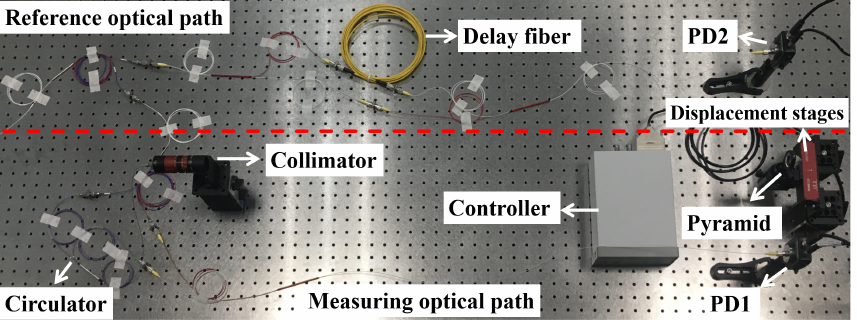
Figure 5. The experimental